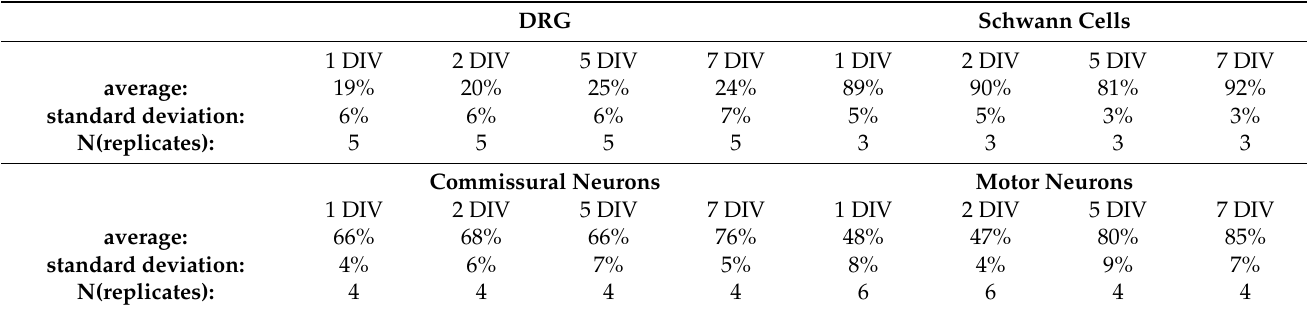
Table 1. Percentage of ciliation of dissociated neurons. Detailed values for Figures 6 and 7. DRG Schwann